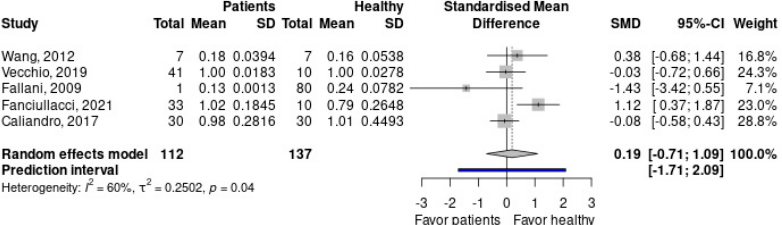
Figure A1. Outliers forest plot. SD: standard deviation; SMD: standardized mean difference; 95%CI: 95% confidence interval; Tau 2 : τ 2 between studies variance estimation; p : Cochran Q test p value; I 2 : proportion of the variance in observed effect is due to variance in true effects rather than sampling error [7,8,10,12,13].